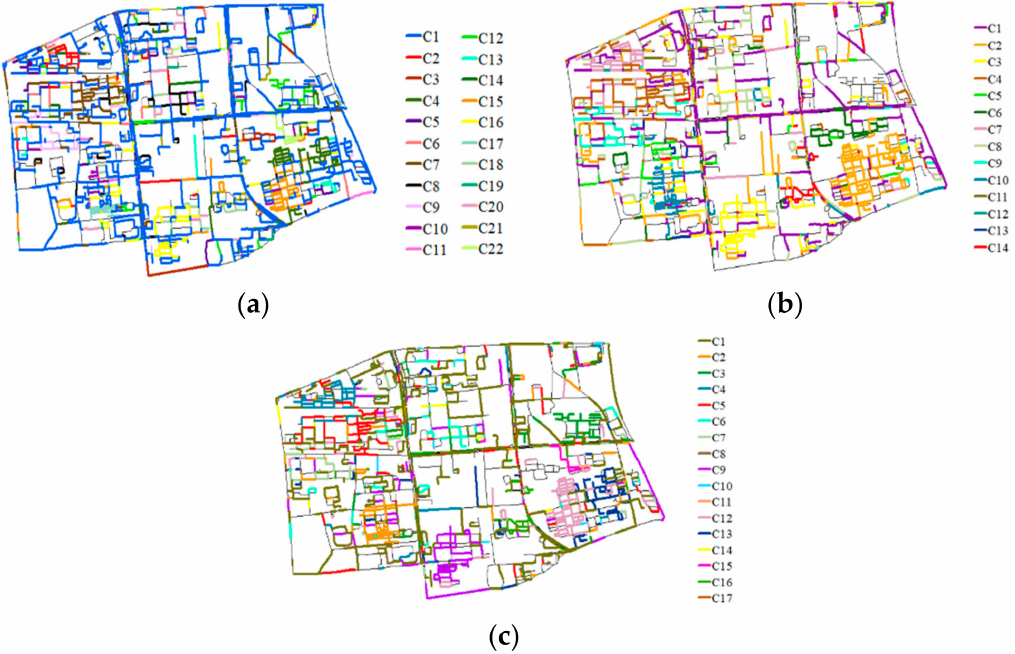
Figure 6. Communities identified by DYNMOGA: ( a ) snapshot 1; ( b ) snapshot 2; ( c ) snapshot 3.